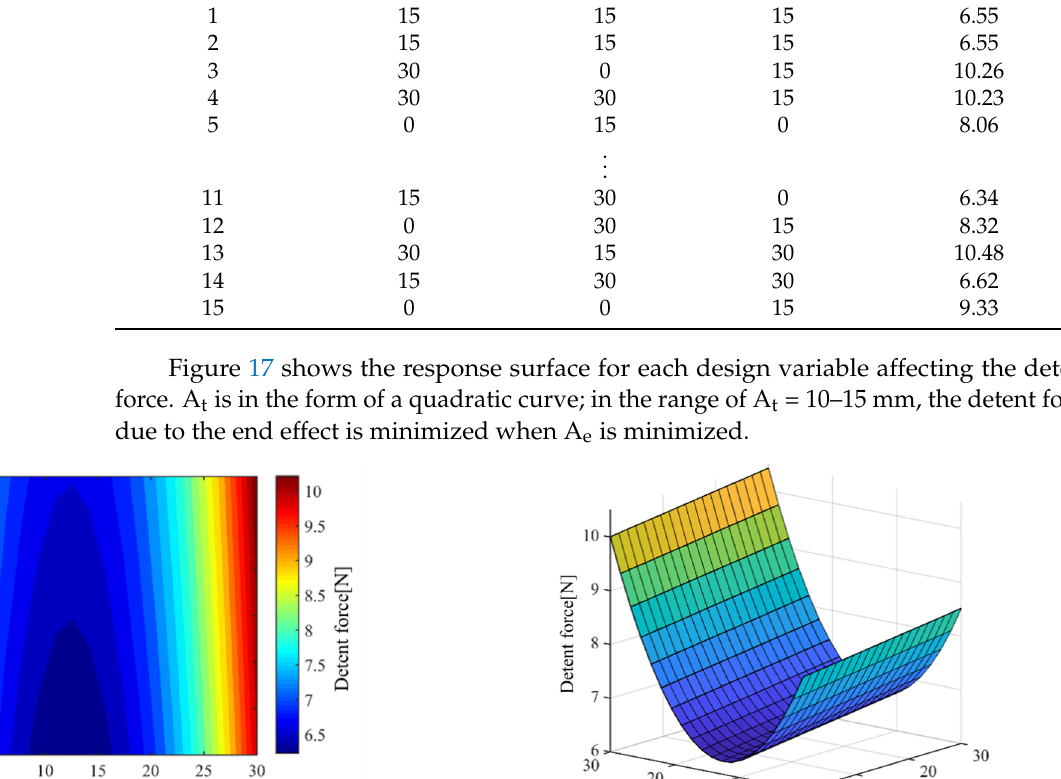
Figure 19b shows a comparison between the harmonic components of the initial and optimized models. As shown, all the components except for the 1st- and 5th-order harmonic components decreased; additionally, the 6th-order component (with the largest value) significantly